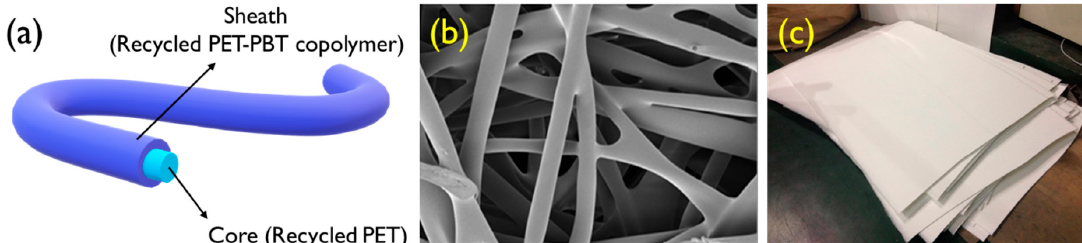
Figure 2. ( a ) Schematic illustration of the recycled bicomponent polyester filament fiber, ( b ) scanning electron microscope image (mag. × 300), and ( c ) photograph of the thermal-bonded nonwoven (R-RM nonwoven) formed therefrom. Table 1. Specification of the recycled rapid melting PET fiber (R-RM) nonwoven.